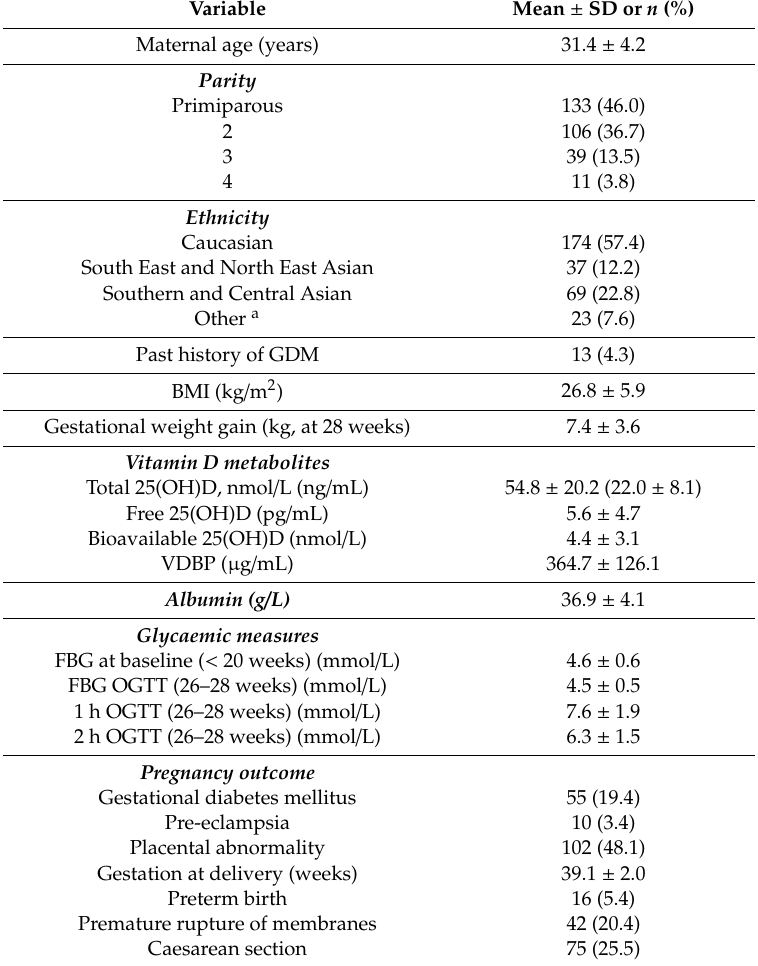
Table 3. The sample demographic, anthropometric, and biochemical characteristics and maternal pregnancy